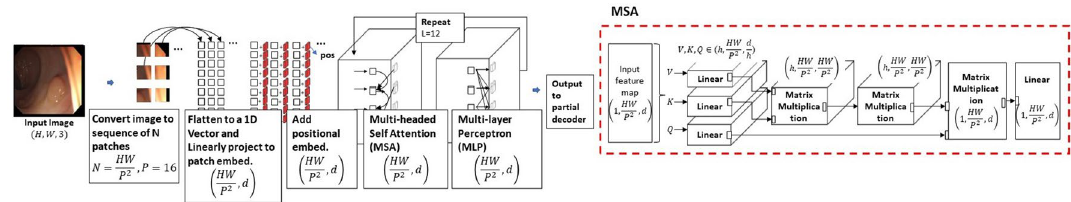
Figure 3. Details of the transformer encoder with MSA